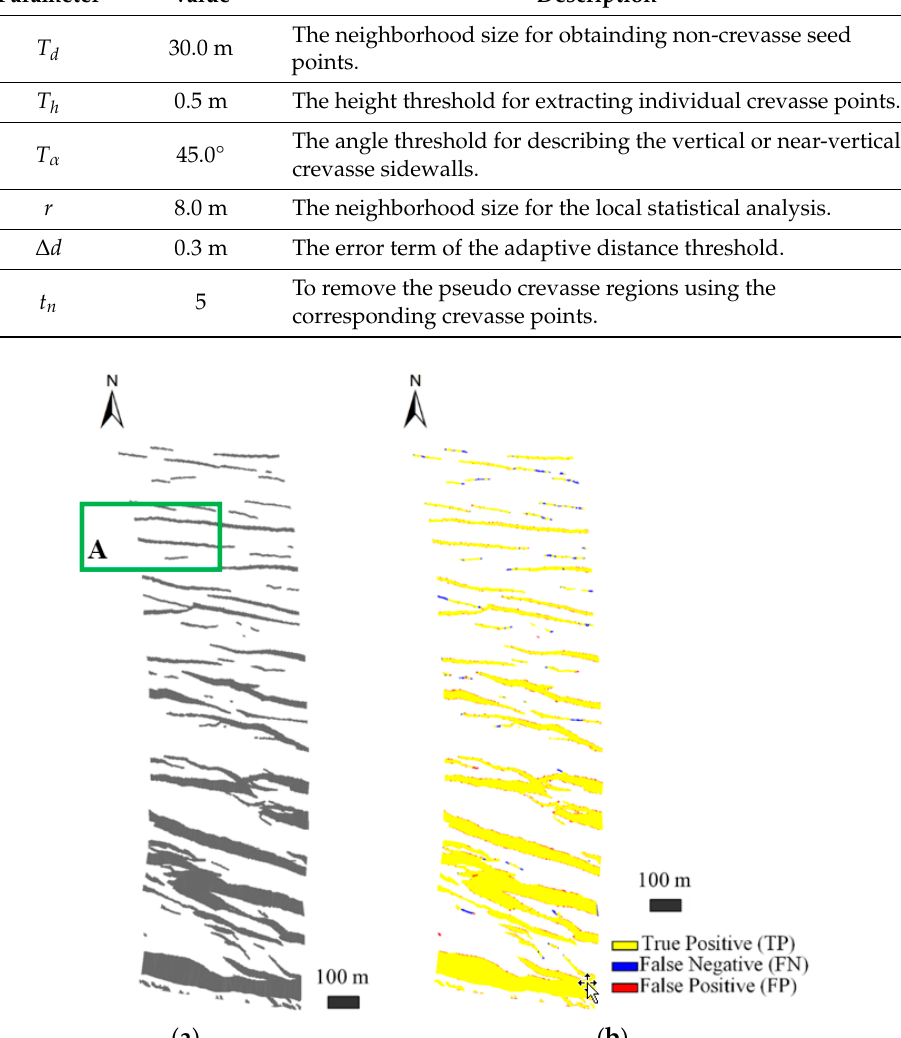
Figure 6. Extracted crevasses for Site 1 and quality evaluation. ( a ) Result of the detected crevasse regions. ( b ) Evaluation result for the crevasse region detection.